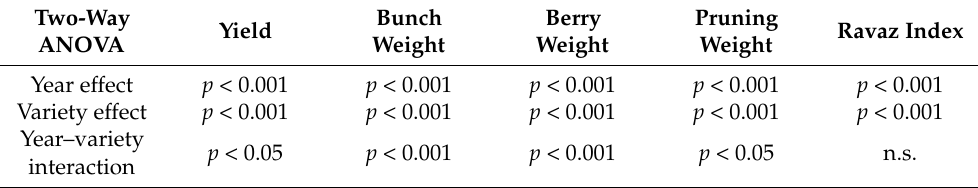
Bunch Berry Yield Weight Weight